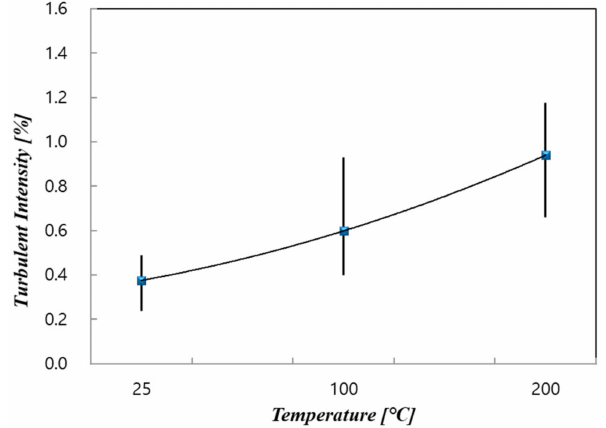
Figure 9. TI measurement increasing the temperature; 25 to 200 ◦